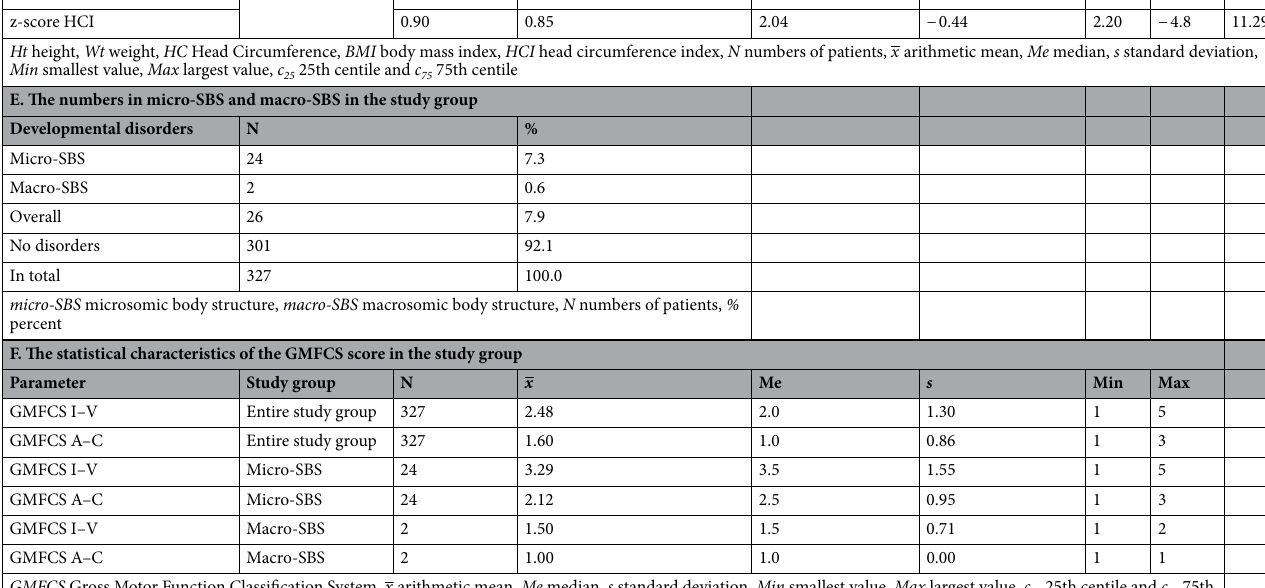
Table 1. The diagnostic criteria for micro/macro-SBS (A), the level of GMFCS (B), the division of group, the numbers in subgroups (C), the statistical characteristics of z-scores: Ht, Wt, HC, BMI, HCI (D), the numbers in micro-SBS and macro-SBS in the study group (E), the statistical characteristics of the GMFCS score in the study group